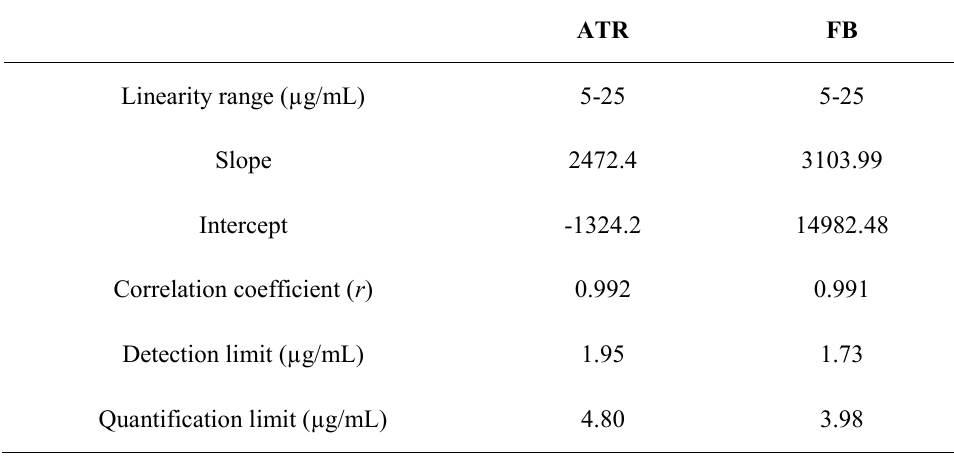
Table 2: Characteristics of the linear regression analysis of ATR and